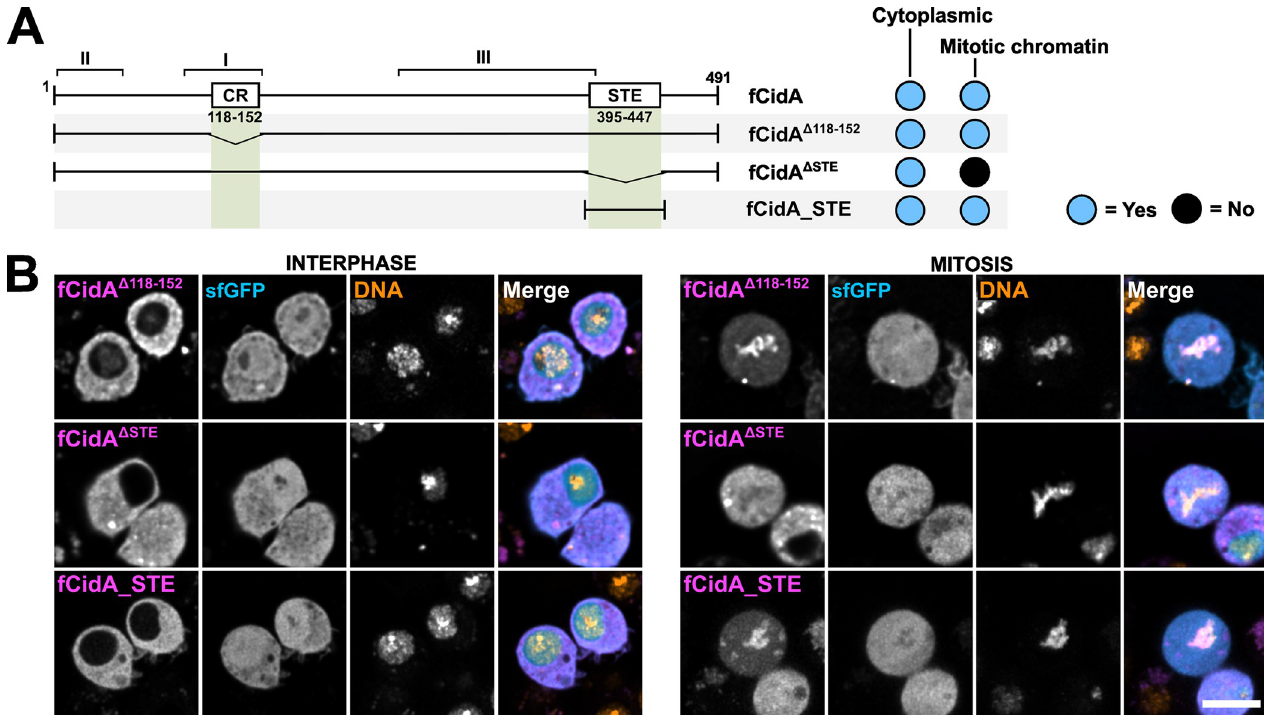
Fig 4. CidA STE is a chromatin binding domain. (A) Schematic view of CidA and its putative domains tested with deletion mutants and their subcellular localization in interphase (i.e. cytoplasmic) and in mitosis (i.e. chromatin) in S2R+ cells. (B) Confocal images of cells expressing the CidA mutants presented in (A). CidA mutants are in magenta, sfGFP in cyan and DNA -Hoechst- in yellow. Scale bar = 10 μ m.